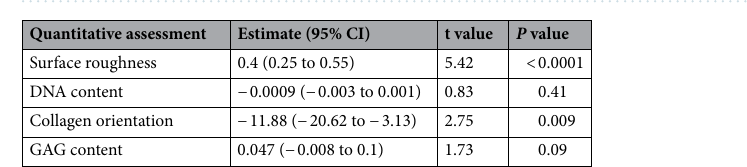
Figure 2. Relationship between Pauli’s histological evaluation and quantitative assessment of human meniscus. A total of 42 samples from seven menisci were included in each study. ( A ) Comparison between histological criteria and four corresponding quantitative values. * p < 0.05. Values are shown as mean ± SEM. ( B ) Correlation between the total histological score and four quantitative values. ( C ) Correlation matrix showing correlation coefficients among variables.